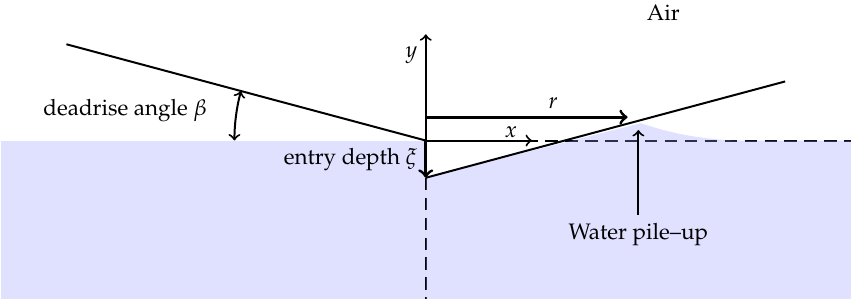
Figure 1. Sketch of the problem of the water entry of a rigid wedge. The wedge enters the water surface at t = 0 ( left ) and penetrates the water by an entry depth ξ as time advances ( right